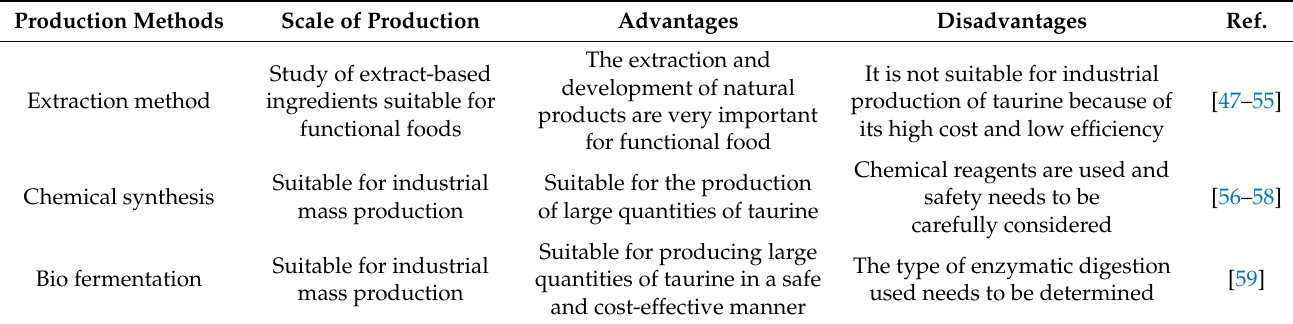
Table 1. Characteristics of different production methods of